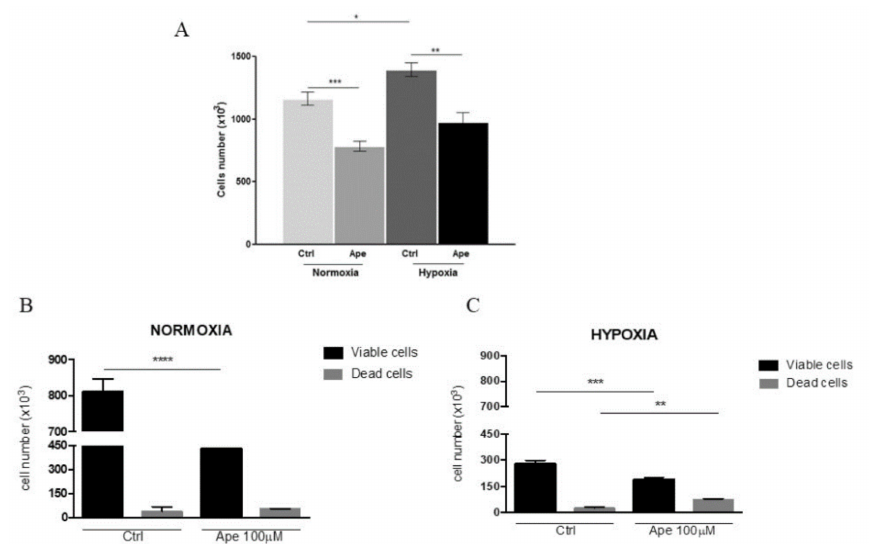
Figure 2. ( A ) Cell number was measured in normoxia and hypoxia and in presence or absence of 100 µ M Ape (24 h). ( B ) Viable and dead cells (revealed by trypan blue staining) were measured after 48 h in normoxia and in presence or absence of 100 µ M Ape; ( C ) Viable and dead cells were measured after 48 h in hypoxia and in presence or absence of 100 µ M Ape.